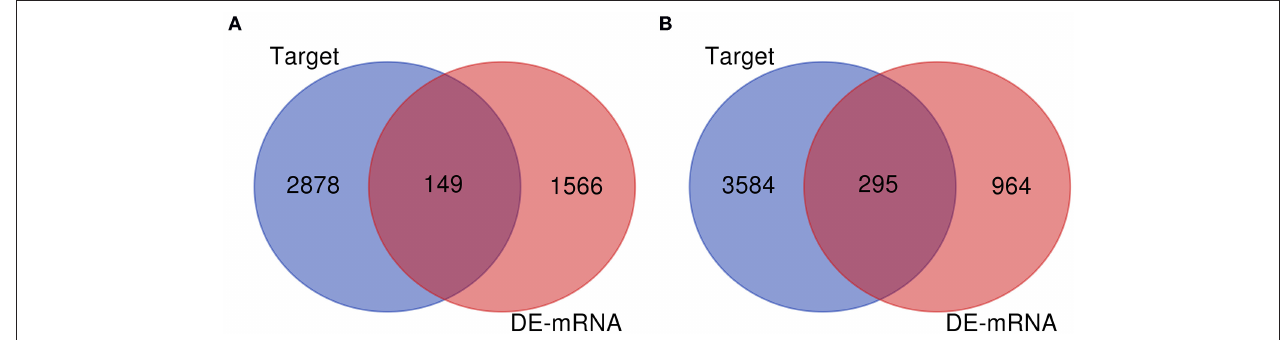
FIGURE 6 | Screen of candidate genes. (A) The intersection of target genes of upregulated DE-miRNAs and downregulated DEGs; (B) the intersection of target genes of downregulated DE-miRNAs and upregulated DEGs.